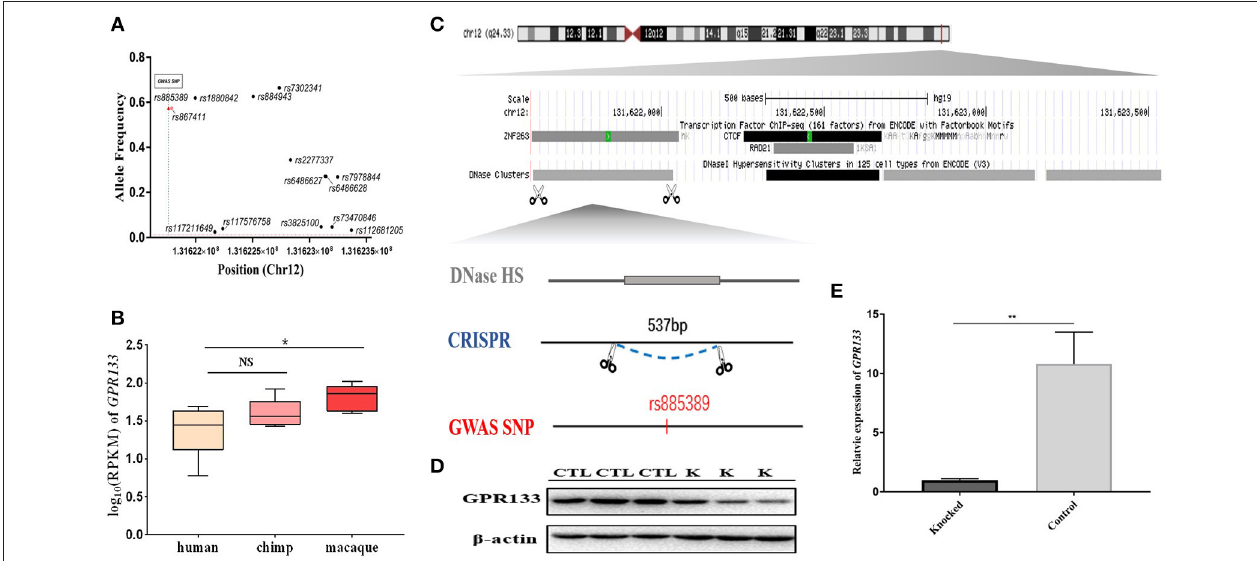
FIGURE 4 | Knockout of a brain-aceDHS that potentially regulates GPR133. (A) Data from the 1,000 Genomes Project demonstrate that there are SNPs with allele frequencies > 1% within the knocked out brain-aceDHS. (B) Expression of GPR133 in human, chimp, and macaque brain tissue. (C) The position of the knocked out aceDHS in the genome. (D) Results of GPR133 western blotting experiment before and after brain-aceDHS knock out. “K,” DHS-knockout cells; “CTL,” control 293T cells. (E) The expression of GPR133 before and after aceDHS knockout. * p < 0.05; ** p < 0.01; *** p < 0.001.